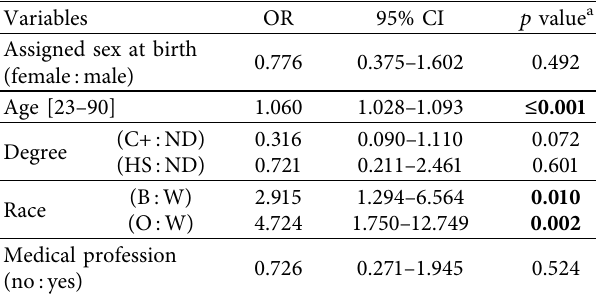
Table 3: Relationship between patients’ demographics and their objective understanding of the procedure, with the propensity to predict poor understanding.